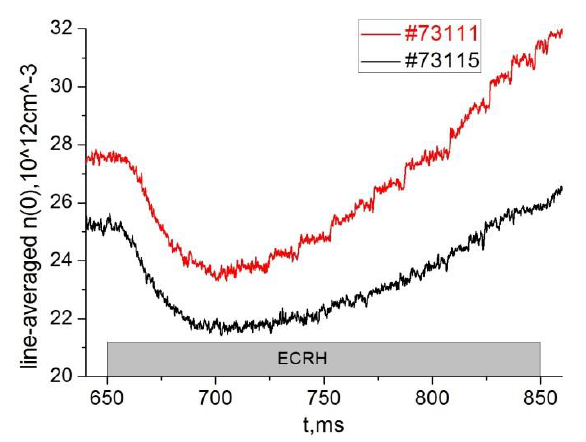
Fig.11. Time evolution of Te ECE (5cm) in comparable shots #73111 (co+contr) and #73117 (co+co).